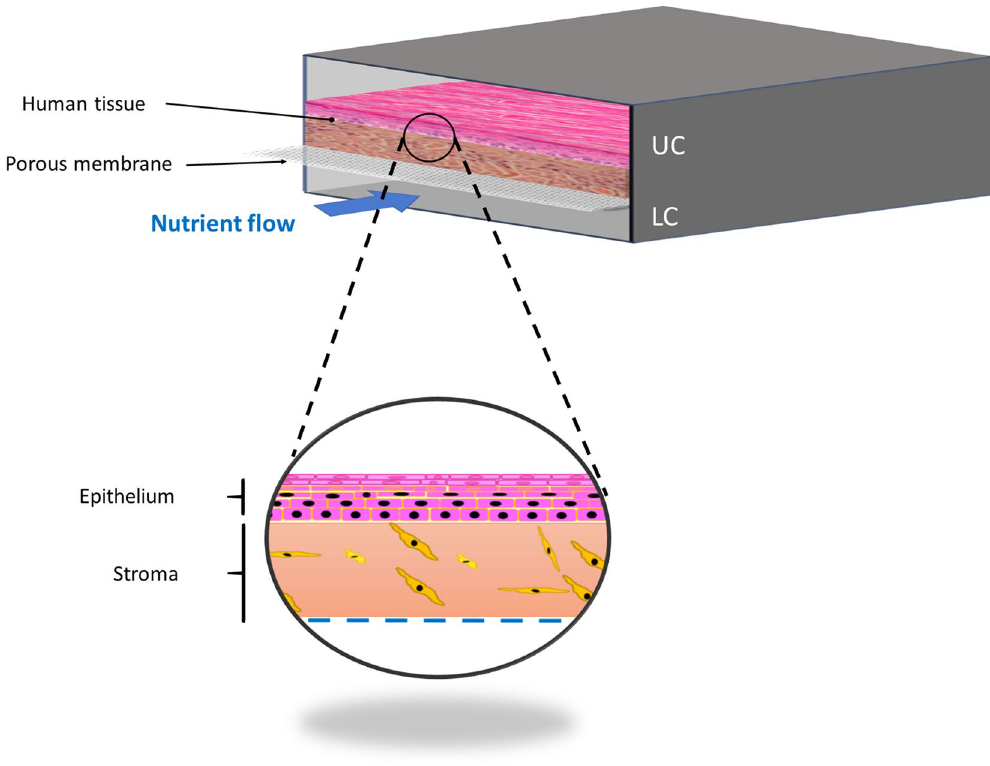
Figure 1. Cross section of the bilayer tissue-on-a-chip chambers and a close view of a human tissue composed of an epithelial and a stromal component, both found in the UC, that is separated from the LC by a porous membrane. There is enough space in the UC for a flow of culture medium, air, or drugs. In the lower chamber, there is a flow to nurture the culture (nutrient